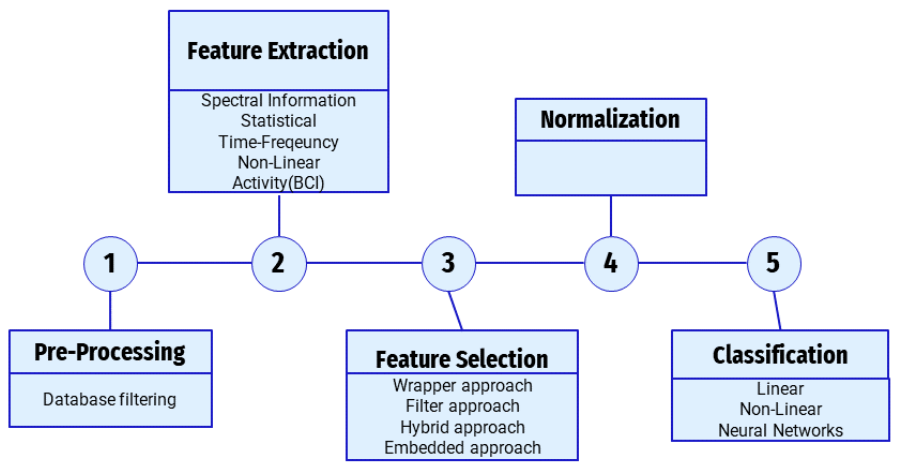
Figure 9. BCI implementation process.